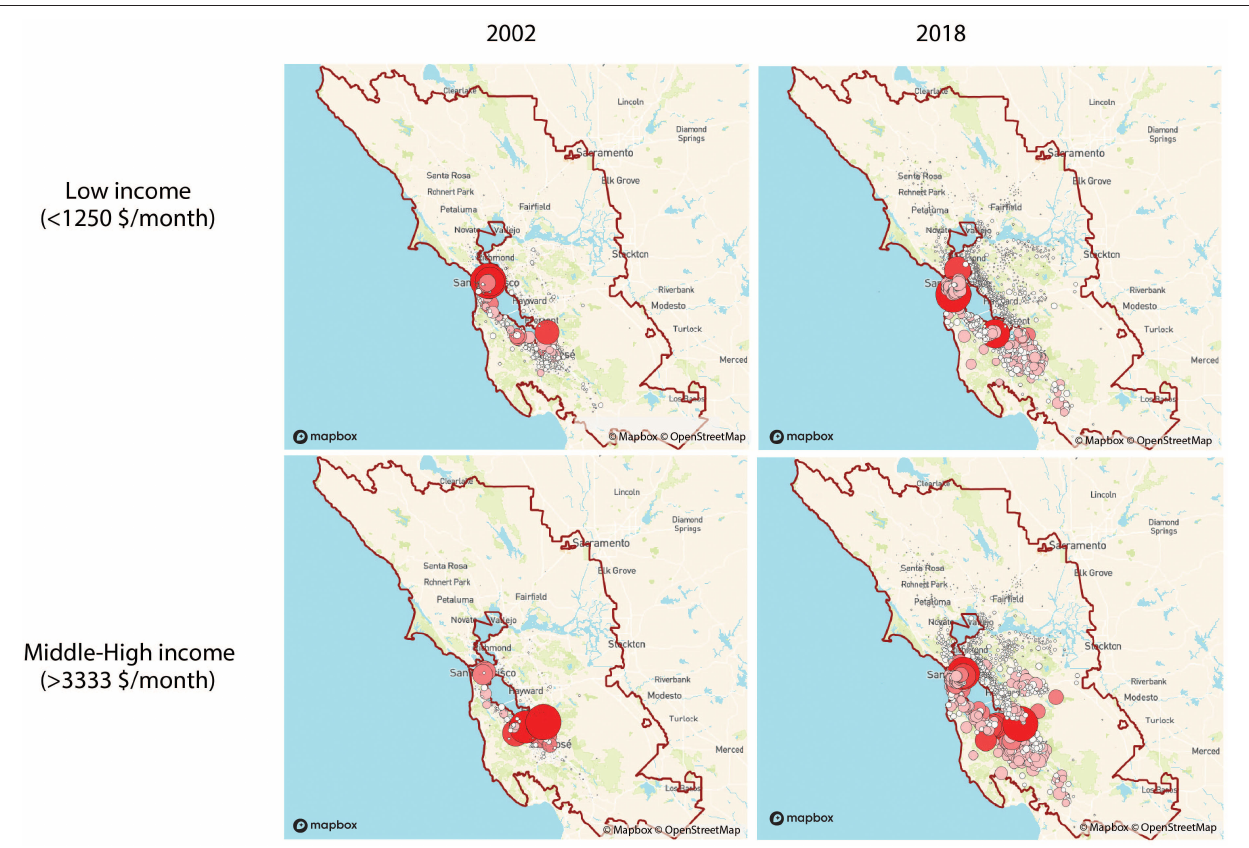
FIGURE 1 | Flow networks of home places of workers commuting to workplaces located in the city centers (around the red circle) based on income groups (weighted out-degree). Node size and color [light (low)-dark (high)] indicates the degree ranking in San Francisco Bay Area.